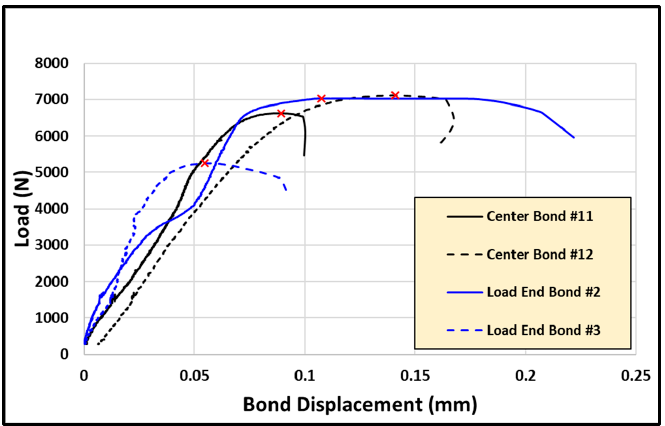
Figure 18. Failure load test cycle versus displacement.